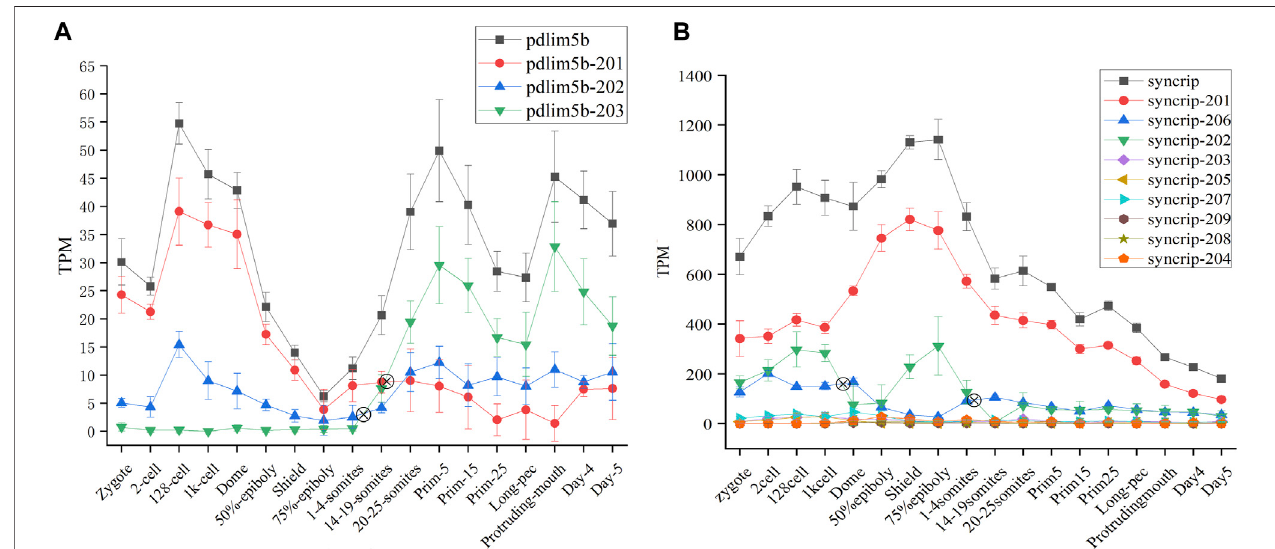
FIGURE 6 | Expression pro fi les of pdlim5b (A) and syncrip genes (B) during 18 time-course stages. The y -axis denotes TPM of transcript isoforms. The symbol denotes switch point. The black line denotes gene expression level and other color lines denote transcript expression levels.